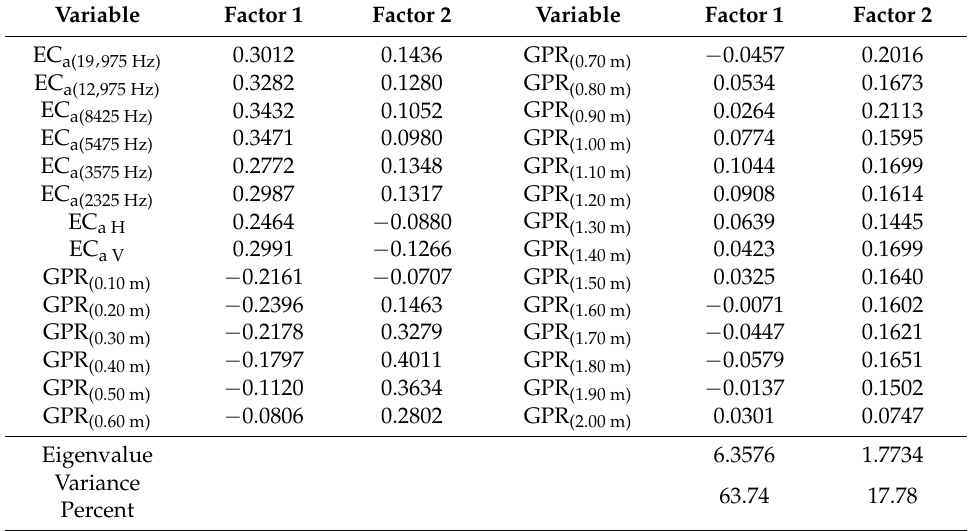
Table 2. Structural composition of the first two regionalized factors of the spherical model at longer range (60 m) with eigenvalue and explained variance